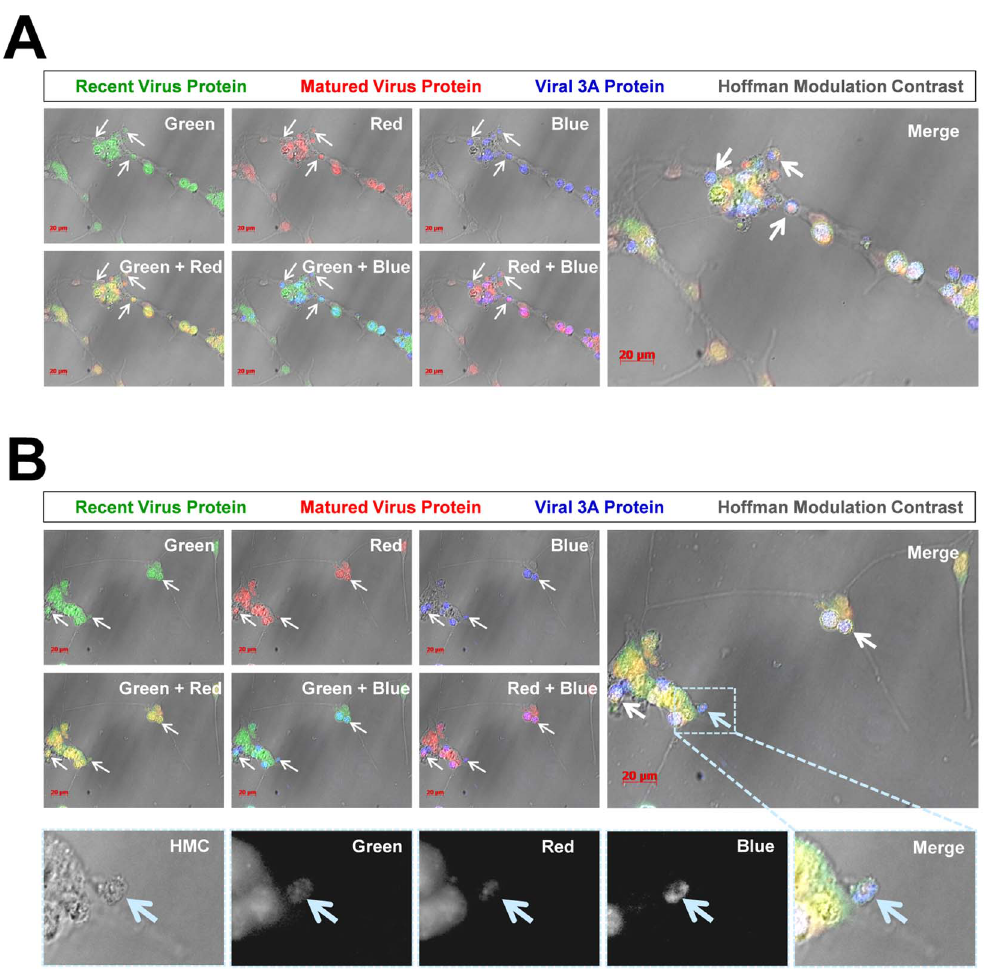
Figure 9. Colocalization of ‘‘fluorescent timer’’ protein and viral 3A protein in NPSCs infected with Timer-CVB3. NPSCs were differentiated for five days and infected with Timer-CVB3 for four days. Infected cells were fixed and immunostaining for viral 3A protein (blue) or observed for native ‘‘fluorescent timer’’ protein expression. Optical sections of stained cells were evaluated for viral protein colocalization utilizing a Zeiss Axio Observer with ApoTome Imaging System. (A) Viral 3A protein colocalized with both recent and matured ‘‘fluorescent timer’’ protein. Also, viral 3A protein was preferentially observed within intracellular microvesicles (white arrows) associated with the cellular membrane. (B) An additional field of infected cells was evaluated, and viral 3A protein colocalized with both recent and matured ‘‘fluorescent timer’’ protein, although the distribution of ‘‘fluorescent timer’’ protein appeared more widespread and viral 3A protein was preferentially associated with intracellular microvesicles. Closer inspection of a single microvesicle (High magnification images highlighted in the dashed cyan box) revealed colocalization of viral 3A protein with both recent and matured ‘‘fluorescent timer’’ protein (cyan arrow; black and white images).